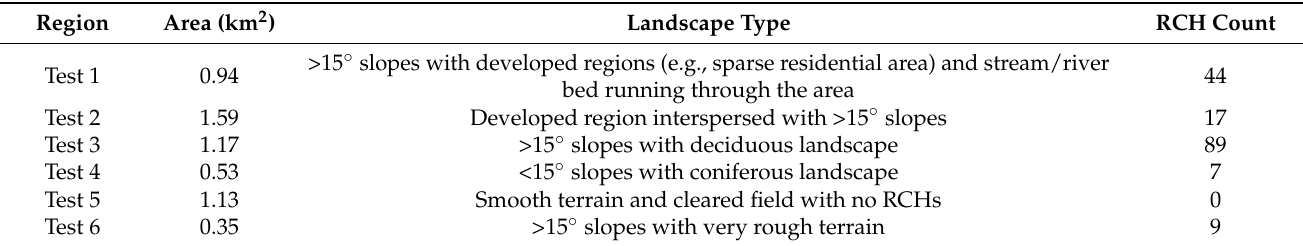
Figure 1. Overview of study region and towns in Connecticut, United States. The background map depicts RCH presence or absence and RCH density (RCH count/km 2 ) [29]. Table 1. Size, landscape type, and RCH count in the test regions.